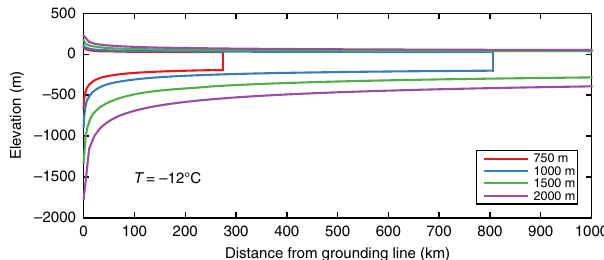
Fig. 2 Pro fi le of an unconstrained ice shelf. Ice shelf elevation with distance from grounding line, following analytical solution for an unconstrained ice shelf 59 . Ice fl ux at the grounding line is dependent on the prescribed grounding line ice thickness, as shown in the legend 60 . For a uniform ice temperature of − 12 ˚ C, no ocean melting and a constant surface mass balance of 0.3myear − 1